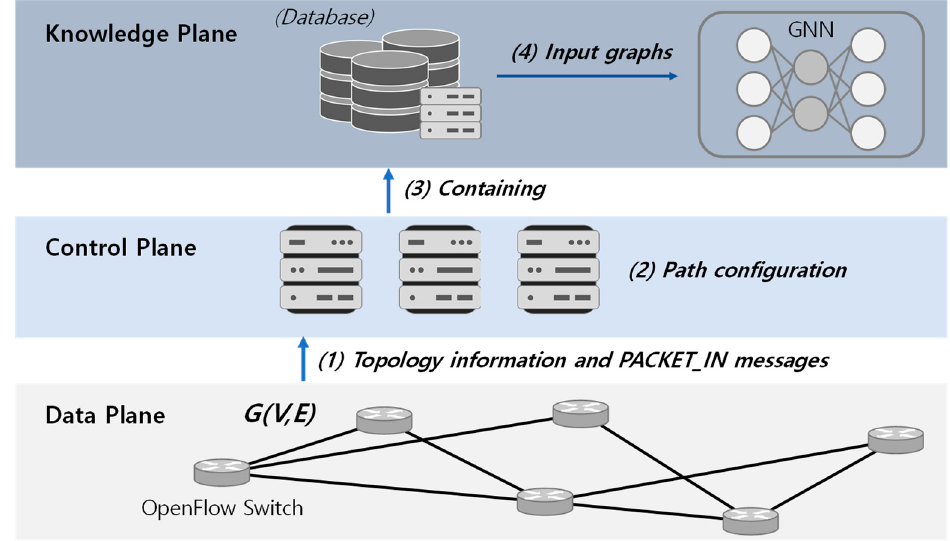
Figure 2. Emerging GNN-based mechanisms in knowledge plane of SDN-enabled architecture.